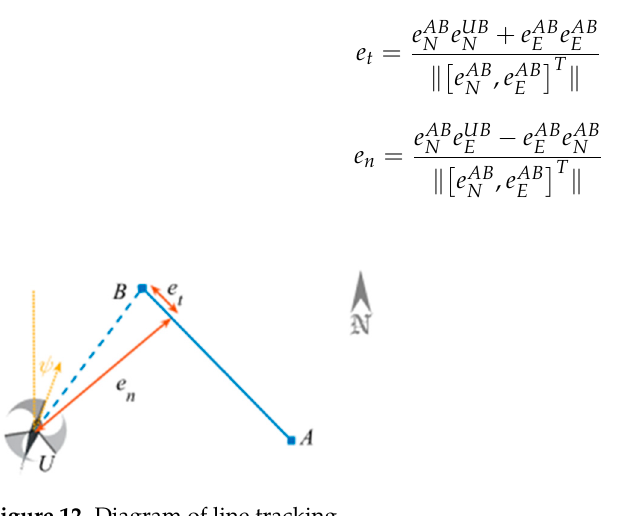
Figure 12. Diagram of line tracking.